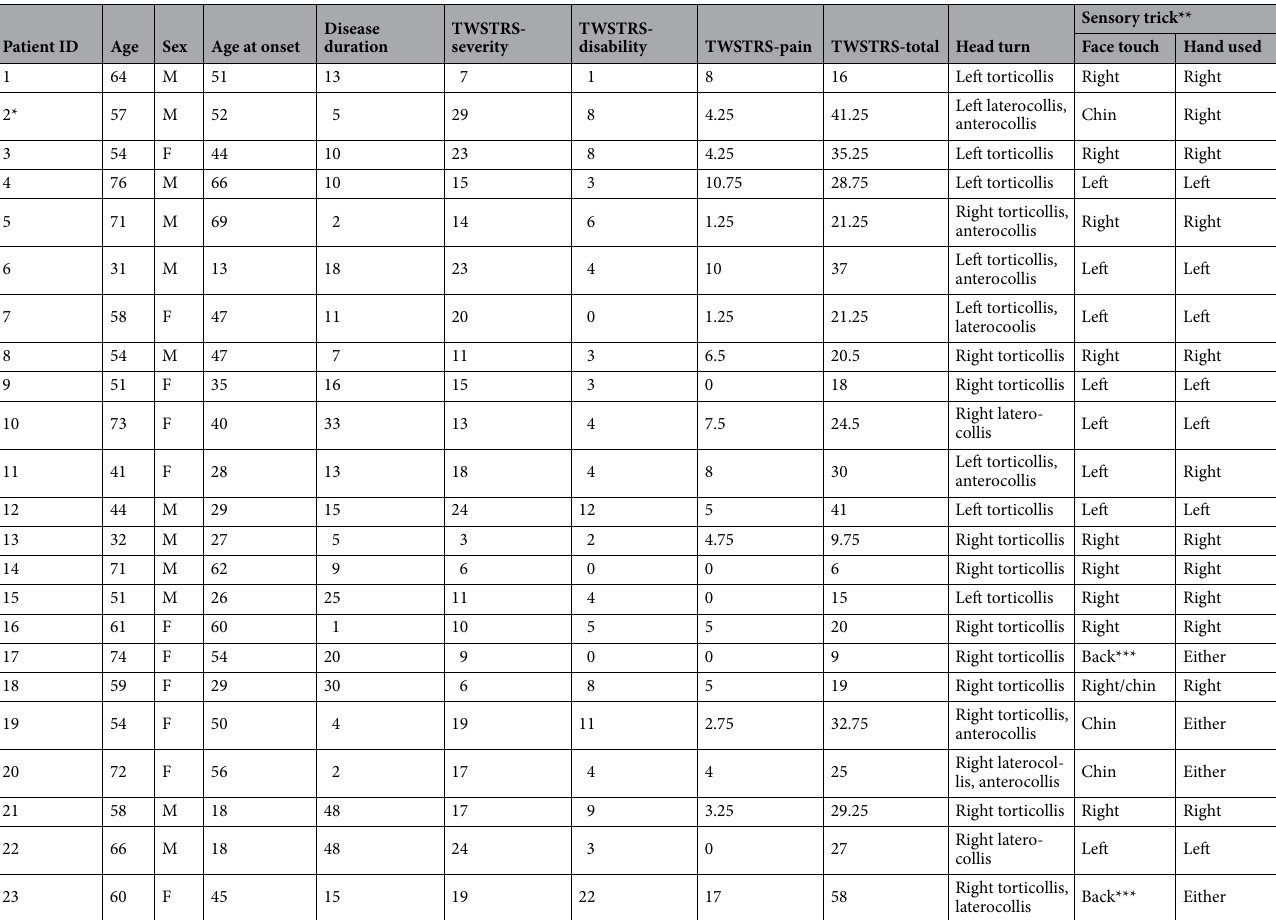
Table 1. Demographics of cervical dystonia patients. *Patient 2 was excluded from the analysis due to motion artifact. **All subjects had sensory tricks but only first 11 subjects underwent additional scans for ‘touch’ and ‘imagine’. ***Back of the head and neck.